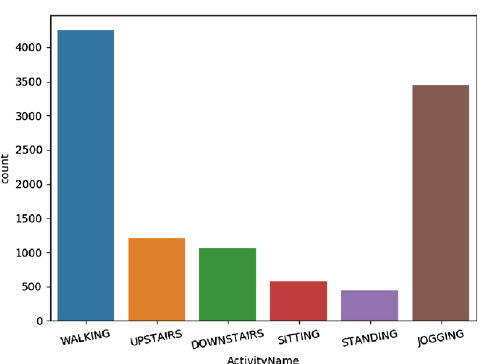
Figure 7. The distribution of activities on WISDM HAR